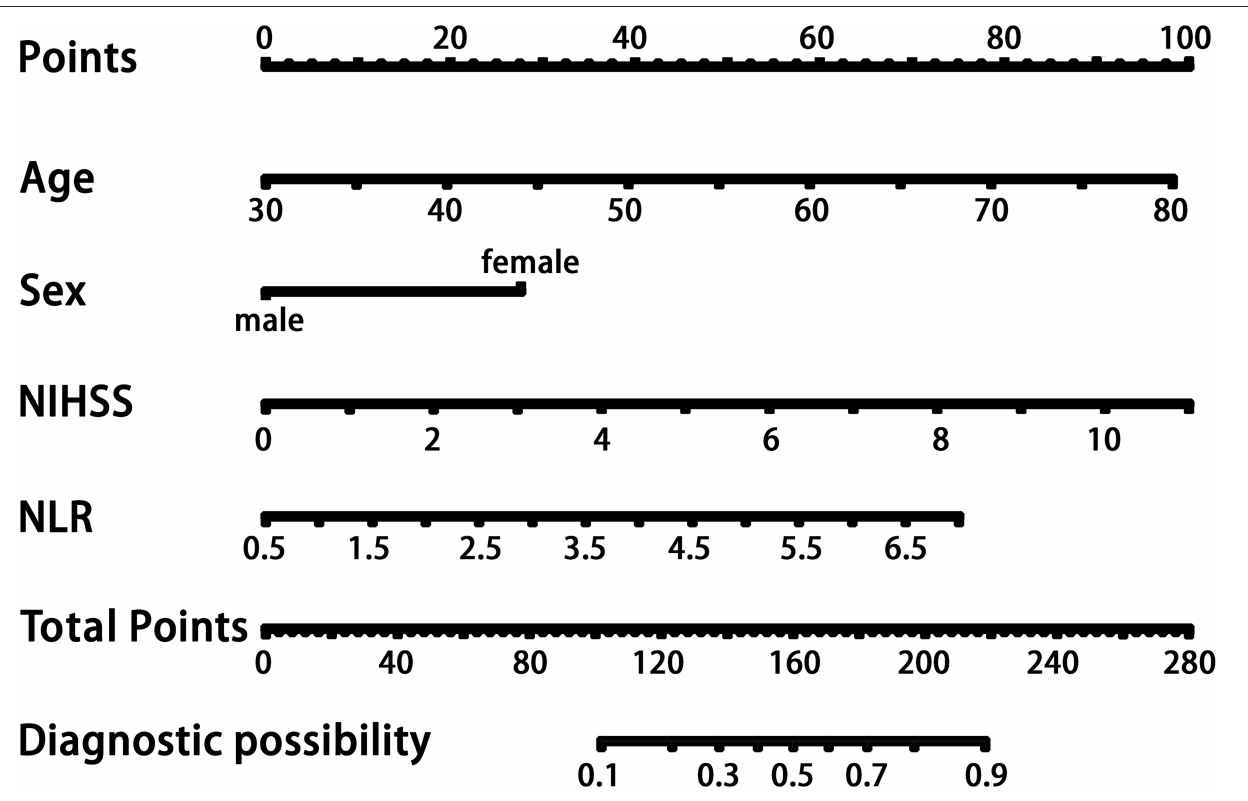
FIGURE 3 | The nomogram for patients with PSCI. Each variable corresponds to its own score, and the sum of these scores corresponds to the probability of PSCI occurring on the probability axis. NLR, neutrophil-to-lymphocyte ratio; NIHSS, National Institutes of Health Stroke Scale on admission; PSCI, poststroke cognitive